Question: What does this figure show? Answer in one sentence.
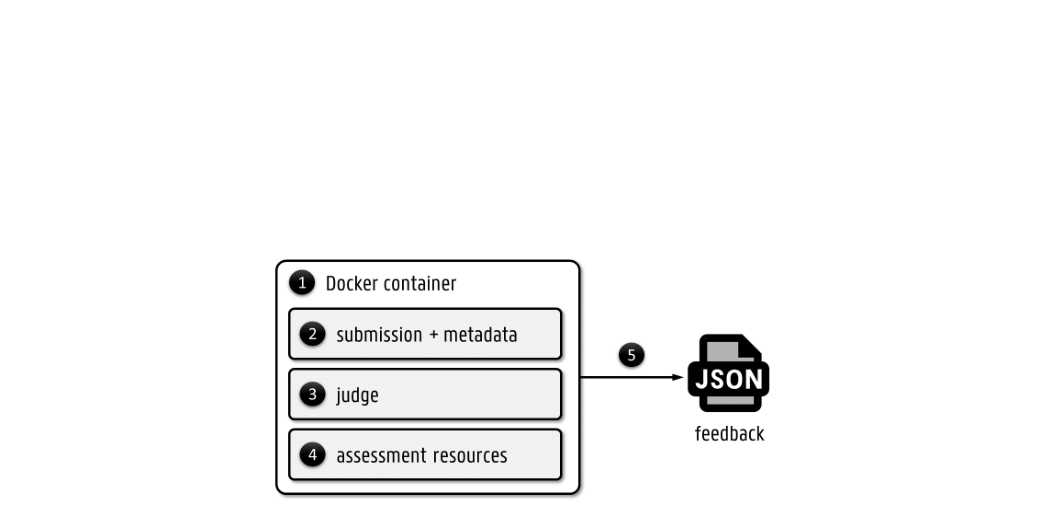
Answer: Outline of the procedure to automatically assess a student submission for a programming assignment. Dodona instantiates a Docker container (1) from the image linked to the assignment (or from the default image linked to the judge of the assignment) and loads the submission and its metadata (2), the judge linked to the assignment (3) and the assessment resources of the assignment (4) into the container. Dodona then launches the actual assessment, collects and bundles the generated feedback (5), and stores it into a database along with the submission and its metadata.